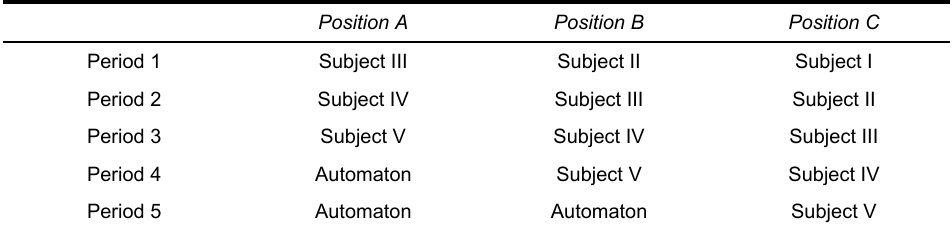
Table 1: Structure of